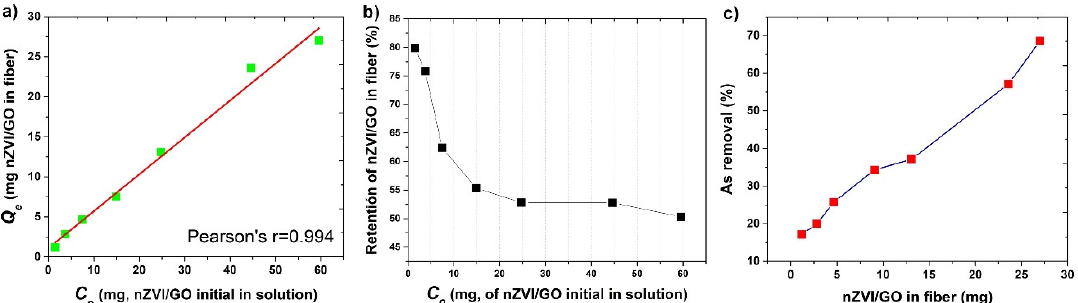
Figure 3. ( a ) Correlation between the initial concentration of nZVI/GO in the solution ( C 0 ) and the amount of material retained on the jute fibers ( Q e ). ( b ) the percentage of retained nZVI on the fiber concerning the initial amount added to the activation solution, ( c ) removal percentage of As from the fibers with varying mg of activation.